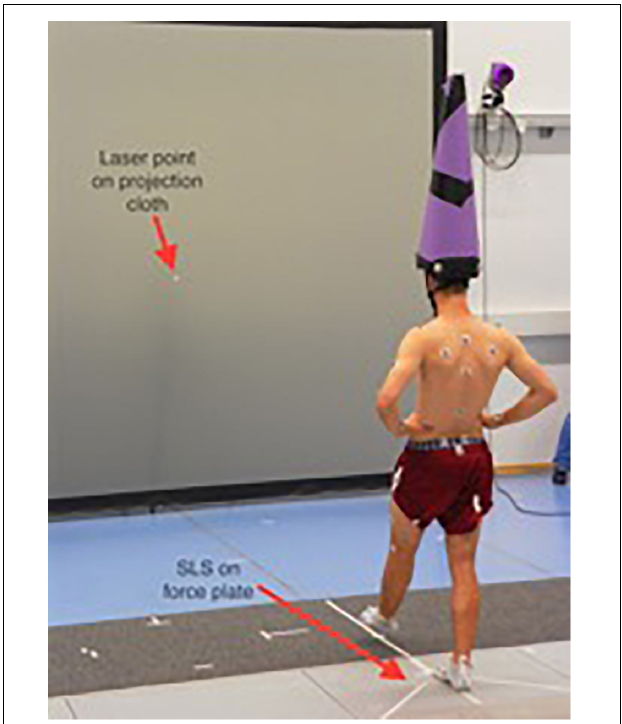
FIGURE 2 | Subject performing single-leg stance (SLS) on force plate.